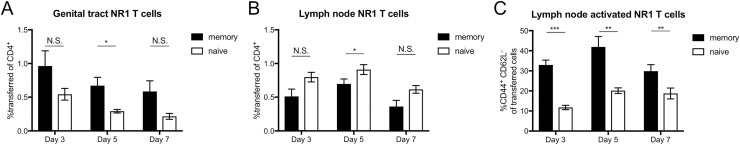
Memory NR1 T cells are more activated than naïve NR1 T cells at multiple time points.Mice received 106 RFP NR1 T cells one day prior to transcervical infection with 5x106 IFU of C. trachomatis. Four weeks later, mice received 106 GFP NR1 T cells and were subsequently reinfected with 5x106 IFU of C. trachomatis. Three, five and seven days post-secondary infection genital tracts were assessed by flow cytometry for (A) NR1 T cells. Draining lymph nodes were also assessed for (B) NR1 T cells and (C) activated NR1 T cells. Data were analyzed using paired t test and are representative of one experiment with 5 mice per group.